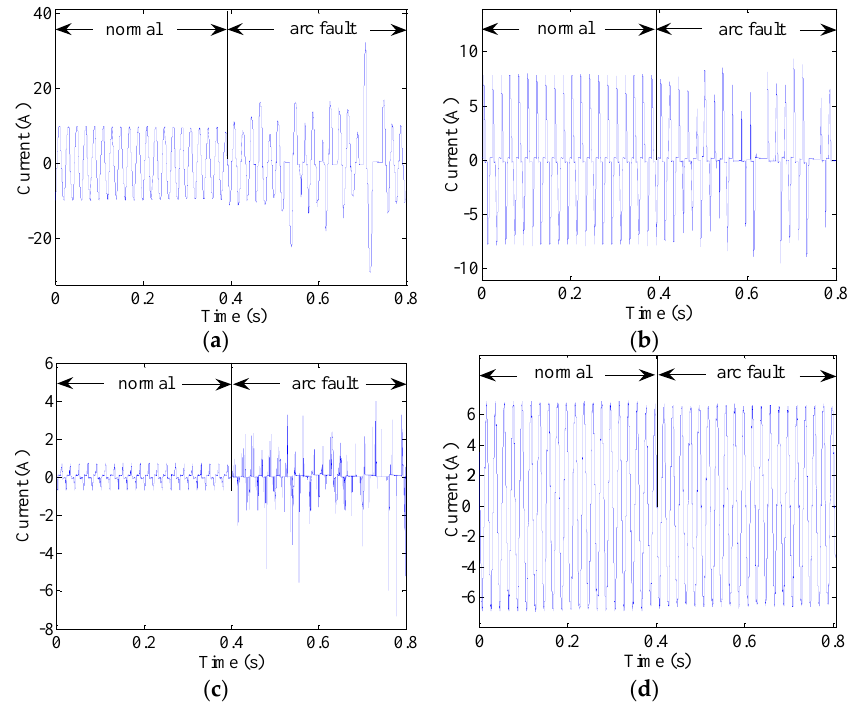
Figure 11. Currents: ( a ) an air conditioner; ( b ) dimming lamps; ( c ) a computer; ( d ) an electric stove.